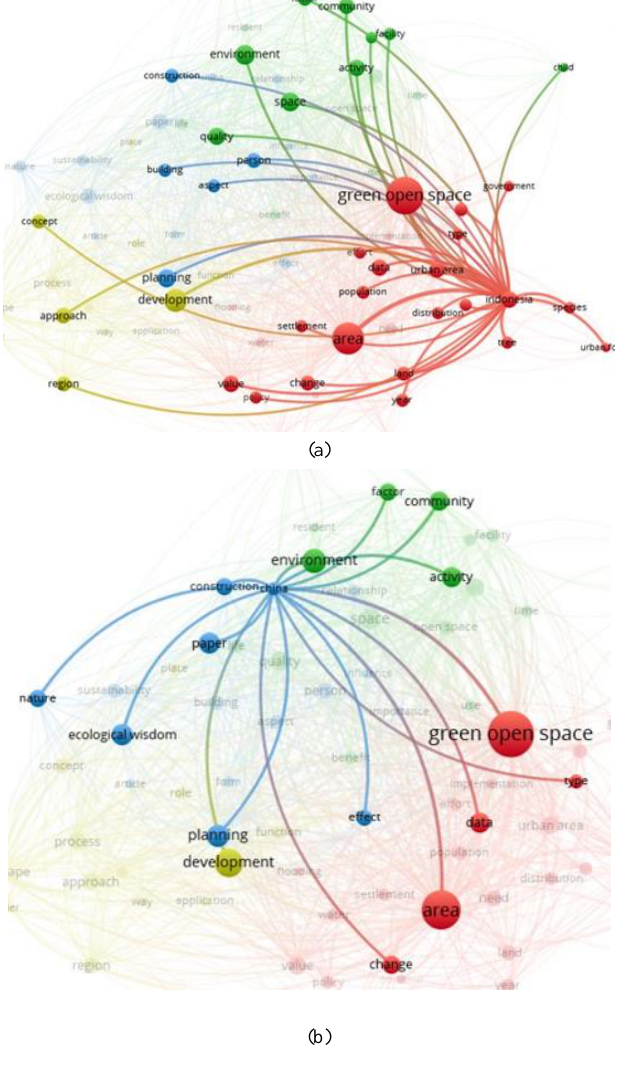
Figure 6. Indonesia (a) and China (b) research trends according to both